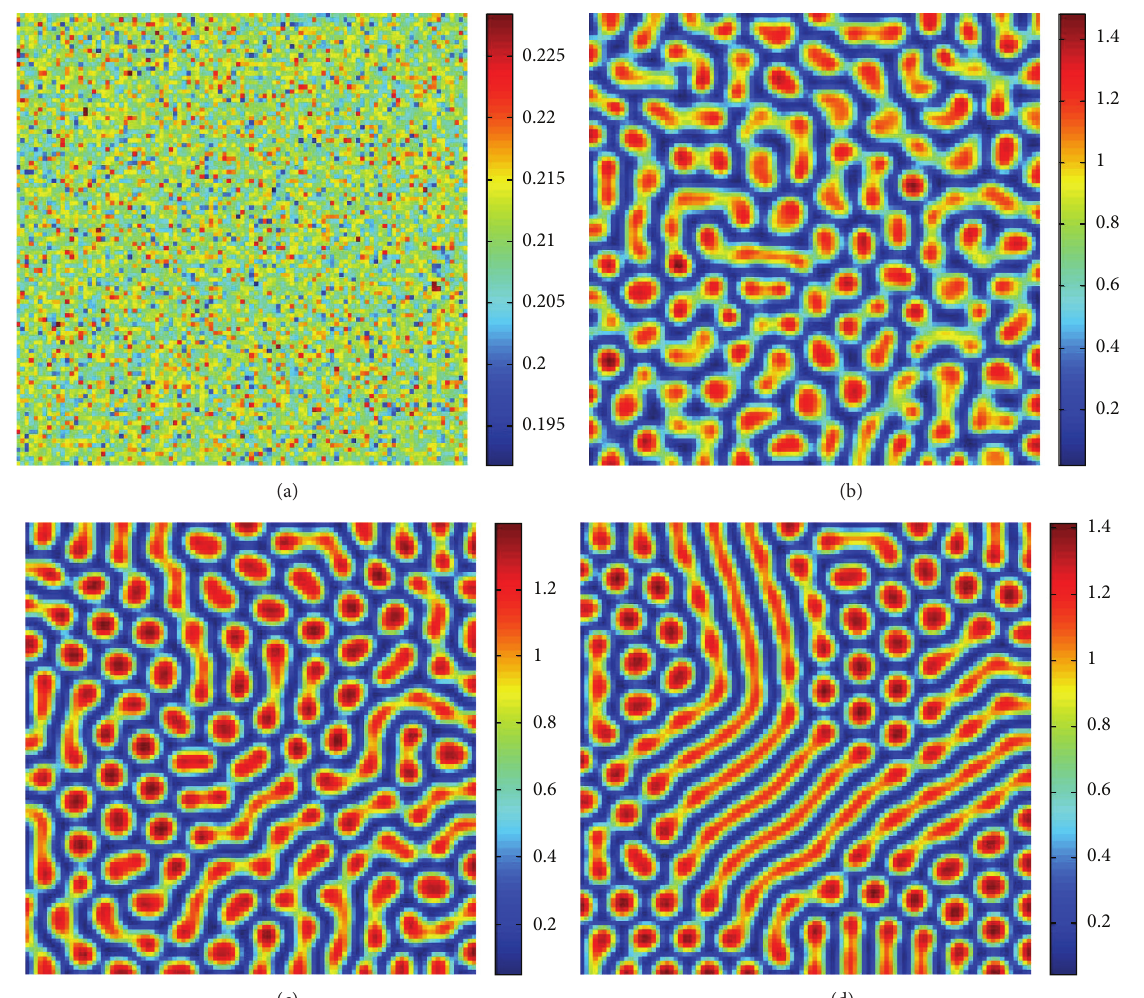
Figure 4: Stripes-spots mixtures pattern formation for model (4) by taking 𝑠 = 1.375 . Other parameters are fixed as (33). Times: (a) 0; (b) 50; (c) 250; (d)